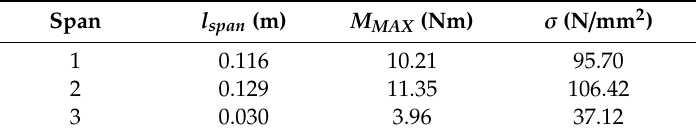
Table 4. Stress values for each